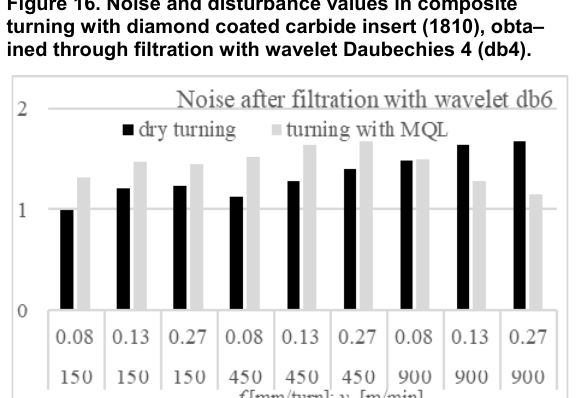
Figure 17. Noise and disturbance values in composite turning with diamond coated carbide insert (1810), obta– ined through filtration with wavelet Daubechies 6